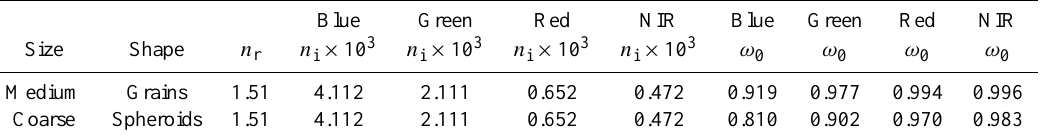
Table 1. Optical properties of MISR dust components.